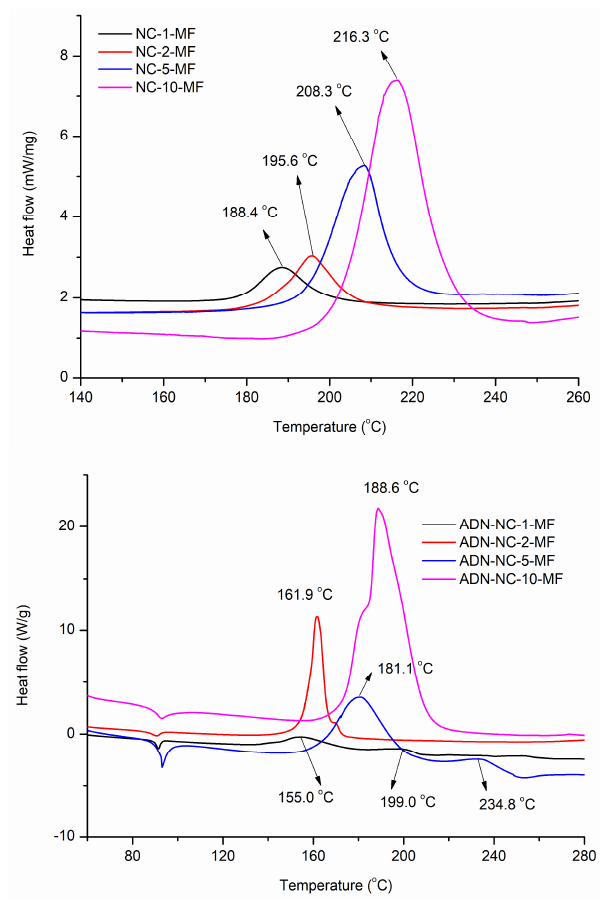
Figure 2. DSC curves of ADN, NC and NC/ADN mixture in closed circumstances. Table 1. The peak temperature and E a of ADN, NC and NC/ADN mixture.